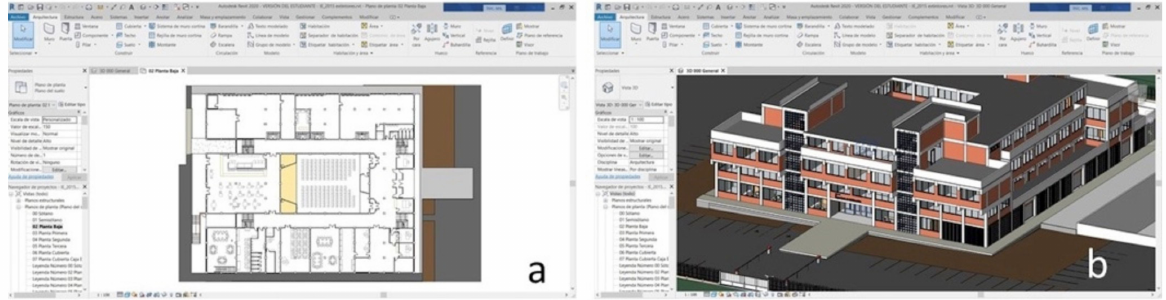
Figure 3. Building Engineering Faculty of the University of La Laguna 2D ( a ) and 3D ( b ) models, performed with Autodesk REVIT by the